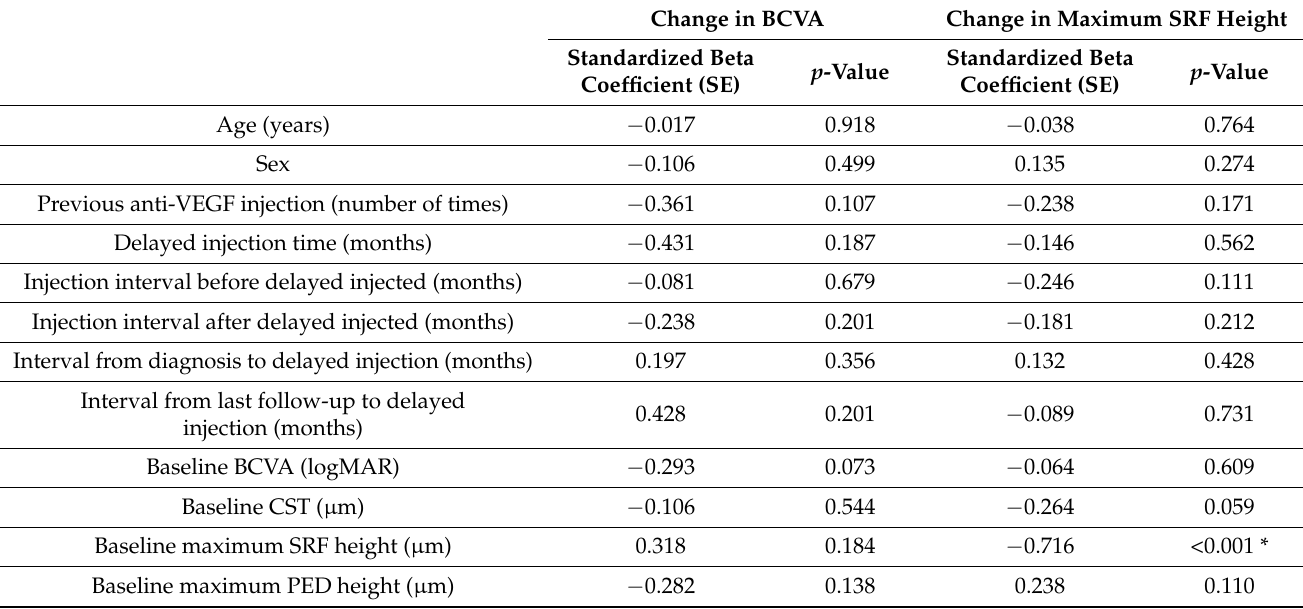
Table 4. Results of multiple regression analysis of the association of changes in BCVA and maximum SRF height at baseline and 6 months’ follow-up (final) with other